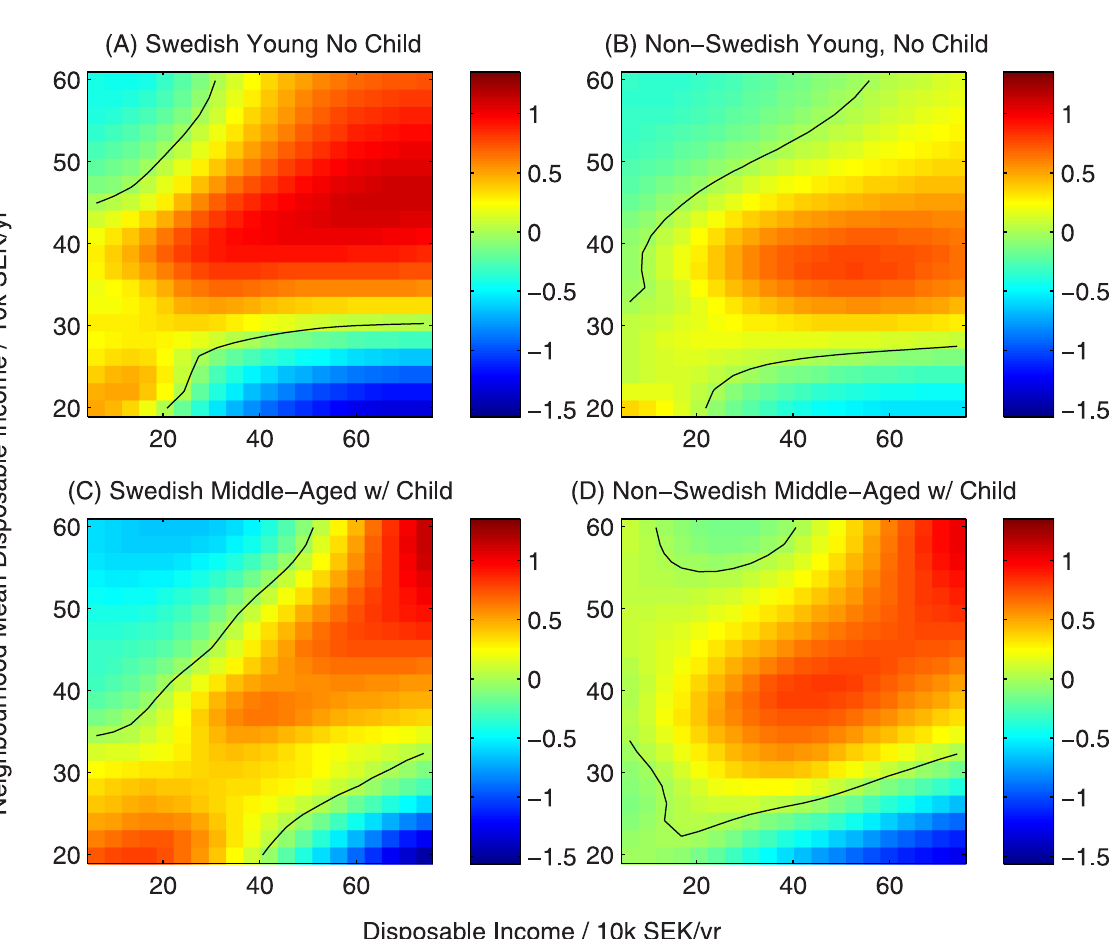
Fig 4. Utility function for neighbourhood income. Black contours represent a utility of zero, indicating no overall preference for or against neighbourhoods with this characteristic.